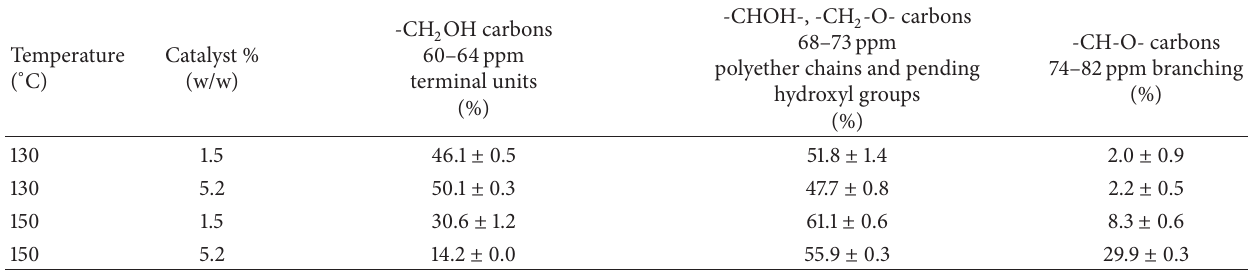
Table 3: Temperature ( ∘ C), catalyst concentration % (w/w), and relative area under spectra region used to quantify and identify different polyglycerol carbons. All experiments were carried out in duplicate.